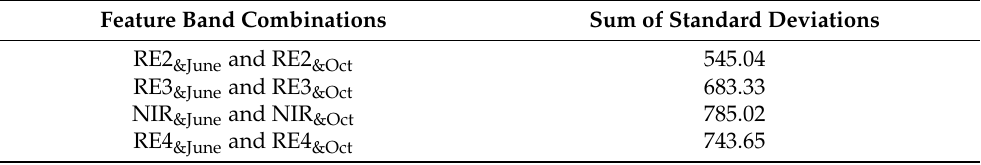
Table 4. Sum of standard deviations of feature band combinations for shaw. Feature Band